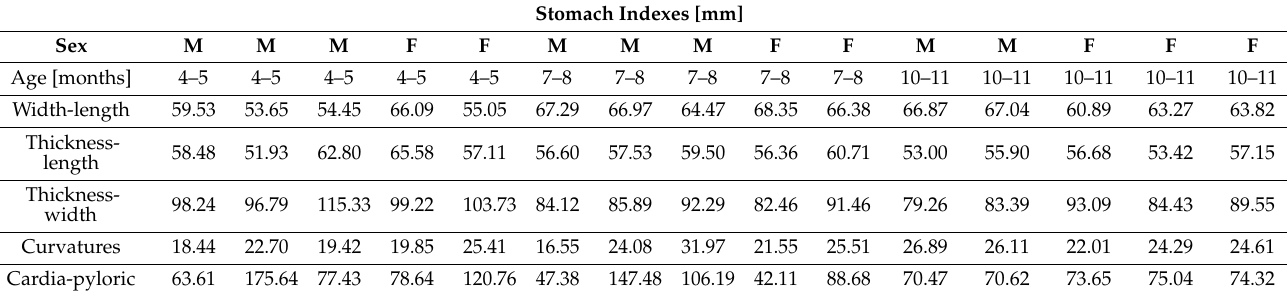
Table 3. Horse stomach